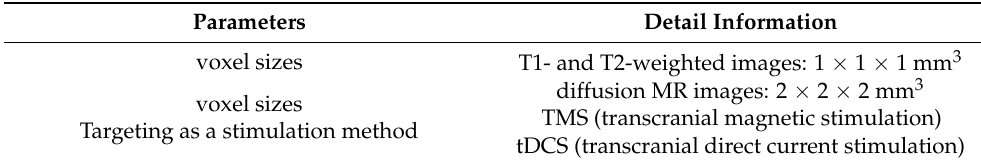
Table 3. Conditions of Ernie head mesh dataset